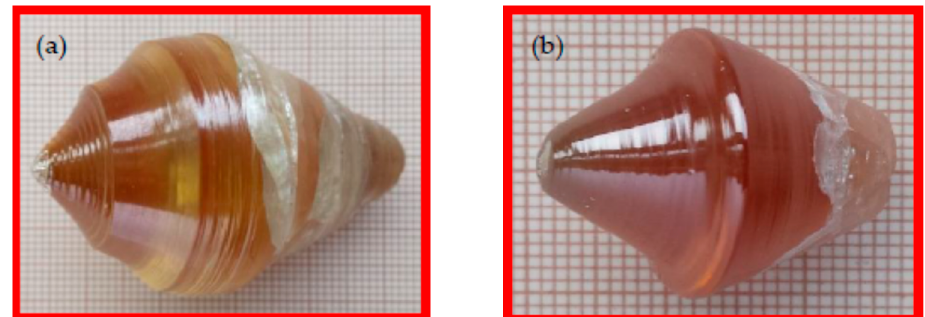
Figure 1. Images of PNMWO single crystals: ( a ) x = 0.001 and ( b ) x = 0.005.